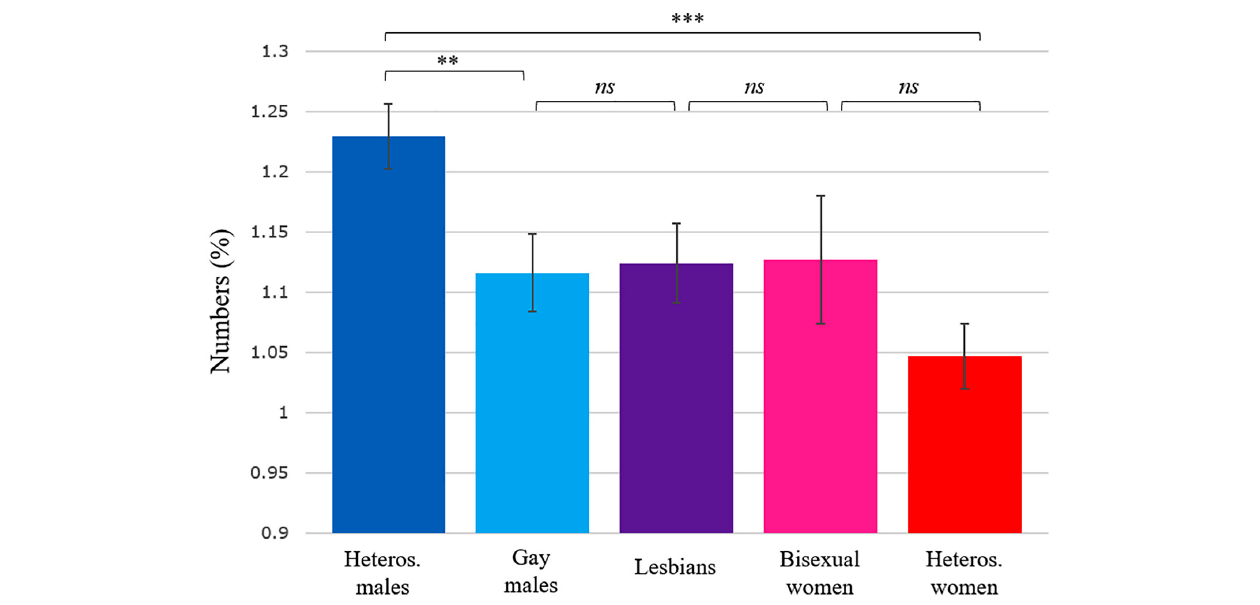
FIGURE 6 | Estimated marginal means and standard errors for frequency of numbers and numerical words in each group of authors. The estimated marginal means are adjusted for differences in publication year and author’s age at publication. *** p < 0.001, ** p < 0.01. ns , non-significant.